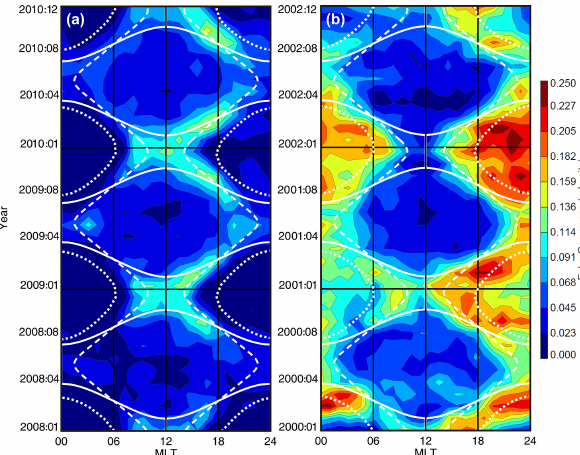
Fig. 3. Saskatoon SuperDARN radar echo occurrence for periods of (a) minimum solar activity (2008–2010) and (b) maximum solar activity (2000–2002) as a function of MLT time. Data in beams 2, 3 and magnetic latitudes of F region echo detection (68 ◦ –84 ◦ ) were considered. The dashed and solid white lines represent the termina- tor line at the earth’s surface for MLAT=72 ◦ and 82 ◦ , correspond- ing roughly to the expected centers of echo bands for one-half-hop and 1.5-hop propagation modes, respectively. The white dotted line shows seasonal variation of an ionospheric point with constant so- lar zenith angle of 108 ◦ (corresponding to a sunset at the height of ∼ 300km) at MLAT=72 ◦ (a similar line for MLAT=82 ◦ differs from the dotted line insignificantly and not